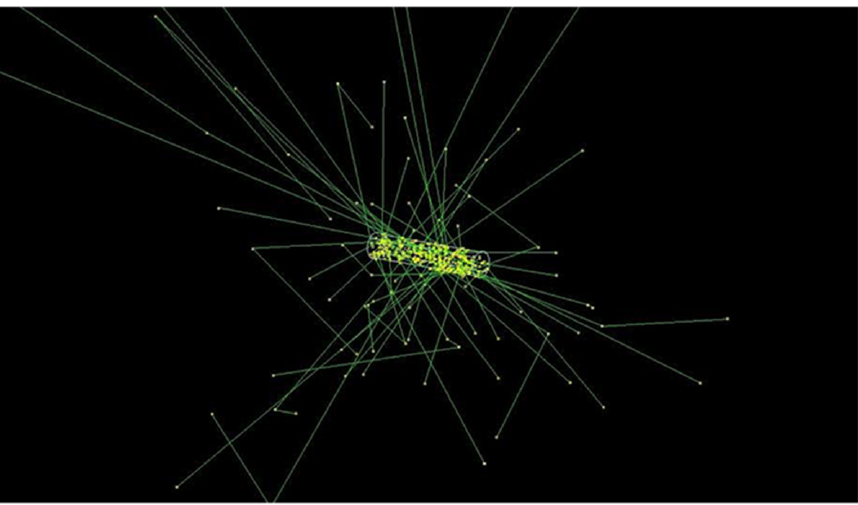
Figure 3. 3D visualization of the Monte Carlo simulation of the seed-like structure, showing photons (green) and electrons (red), which are almost invisible due to the short range.